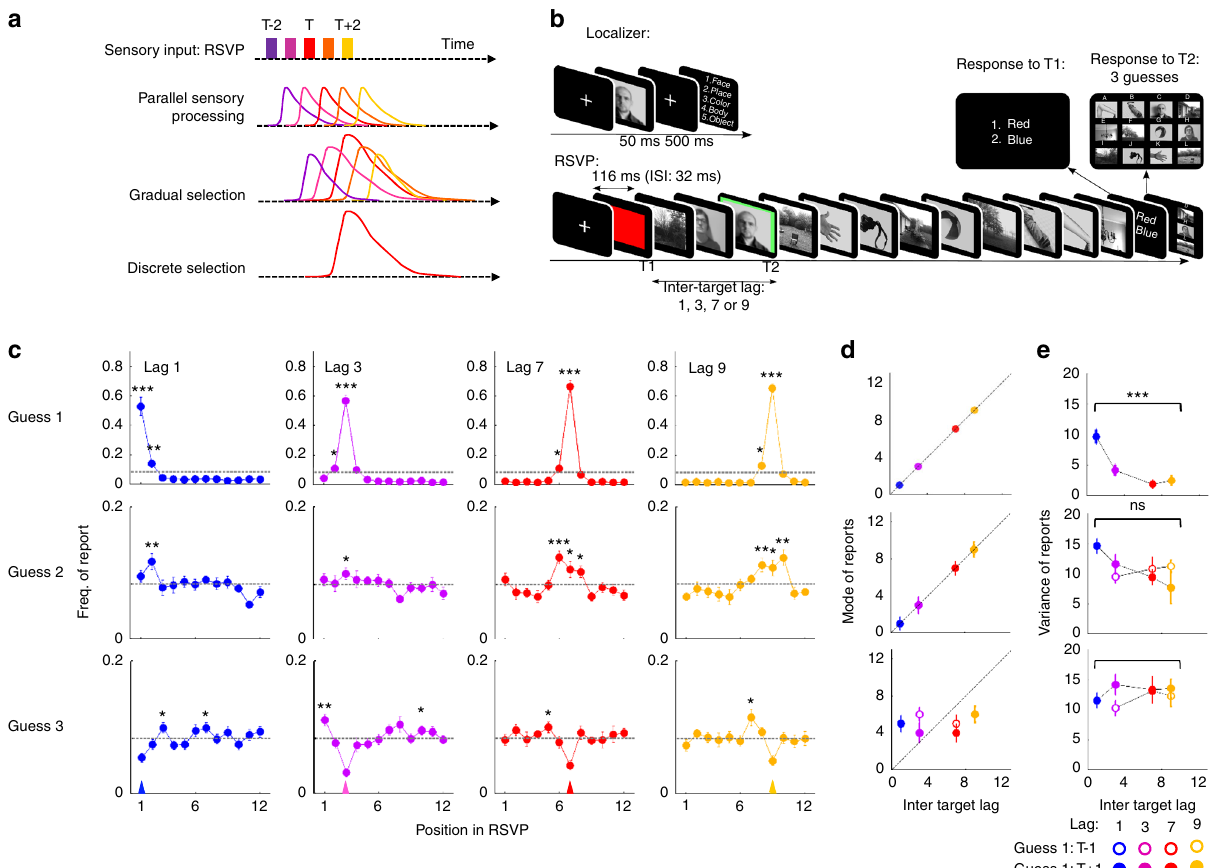
Fig. 1 Experimental design and behavioral evidence for gradual temporal selection. a Schematic representation of parallel and serial model of temporal selection. From top to bottom are represented the stream of stimuli, the activity in sensory areas, the gradual selection hypothesis, and the discrete selection hypothesis. Each colored curve represents the predicted brain response for one stimulus in the RSVP at a certain stage of processing. In both models, stimuli are integrated in parallel at the sensory level. In the gradual selection model, attention selects multiple stimuli simultaneously. All stimuli bene fi t from attentional enhancement but at varying degrees. By contrast, in the discrete selection model, attention is all-or-none and only one stimulus is selected for further processing. b Schematic representation of the tasks. In the localizer task (upper part), one stimulus was presented and subjects had to indicate their category. During the dual-task (lower part), stimuli were presented in a rapid visual stream. Subjects were instructed to fi rst determine the color of the very fi rst stimulus (T1) and then identify the image surrounded by a green square (T2). Subjects made systematically three guesses for T2 by order of preference (i.e., from the most probably correct response to the least probably correct). For copyright reasons, the stimuli used in the experiment are replaced by representative images. c Distribution of subjects ’ reports. Rows represent Guess 1, 2, and 3 and columns represent inter-target lags (blue, magenta, red and orange for Lag 1, 3, 7, and 9, respectively). For each position in the RSVP, the proportion of trials was compared to the chance level. A signi fi cant difference is indicated by an asterisk (* P < .05; ** P < .01; *** P < .001). Error bars represent standard error to the mean. d Average ( ± standard error) mode and variance ( e ) of subjects ’ report distributions as a function of inter-target lag. For Guess 2 and 3 panels, trials were split according to Guess 1 position. Closed symbols: subjects reported T-1 as Guess 1; Open symbols: subjects reported T + 1 as Guess 1. Asterisks represent results of a repeated- measures ANOVA with the inter-target lag as a within-subject factor: * P < .05; ** P < .01; *** P <